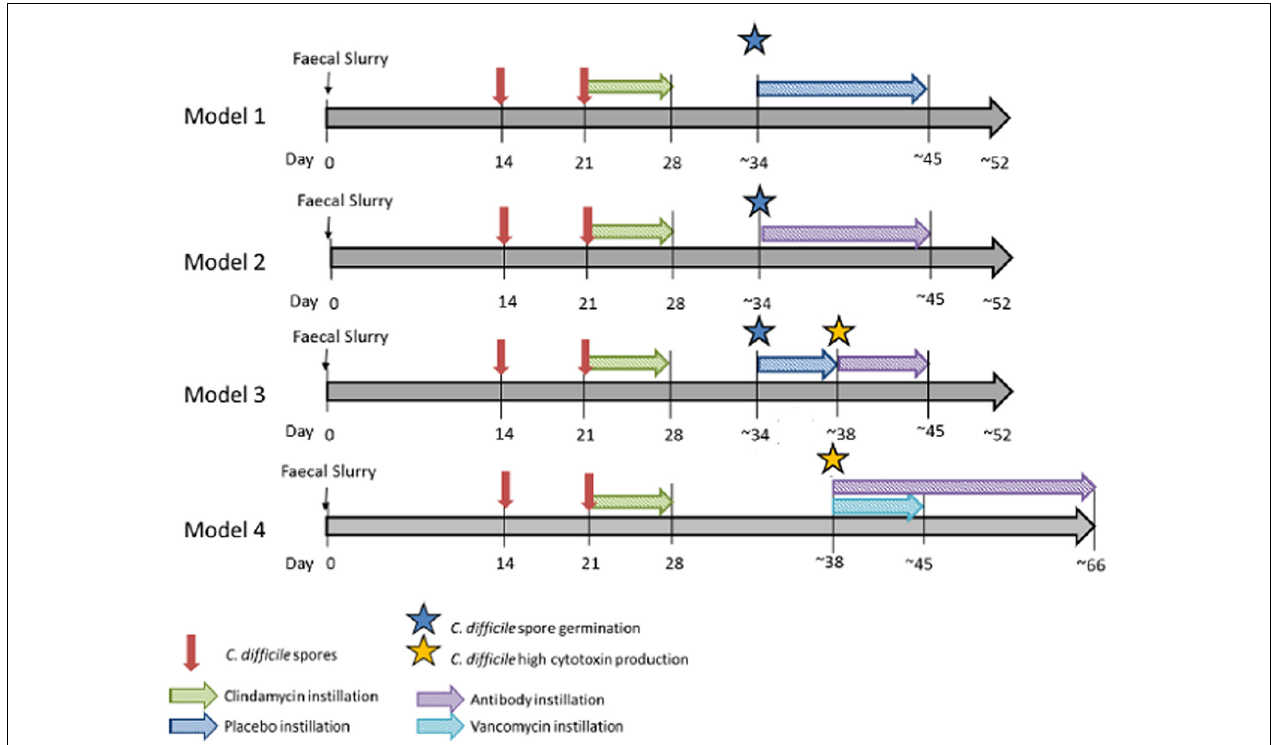
FIGURE 2 | In vitro gut model experimental design. Timeline for gut models, including equilibration of microbial community, induction of CDI and addition of placebo, OraCAb antibodies or antibodies +